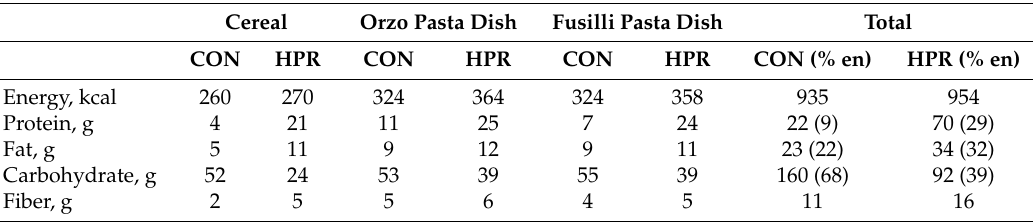
Table 1. Nutrition information for study food portions *